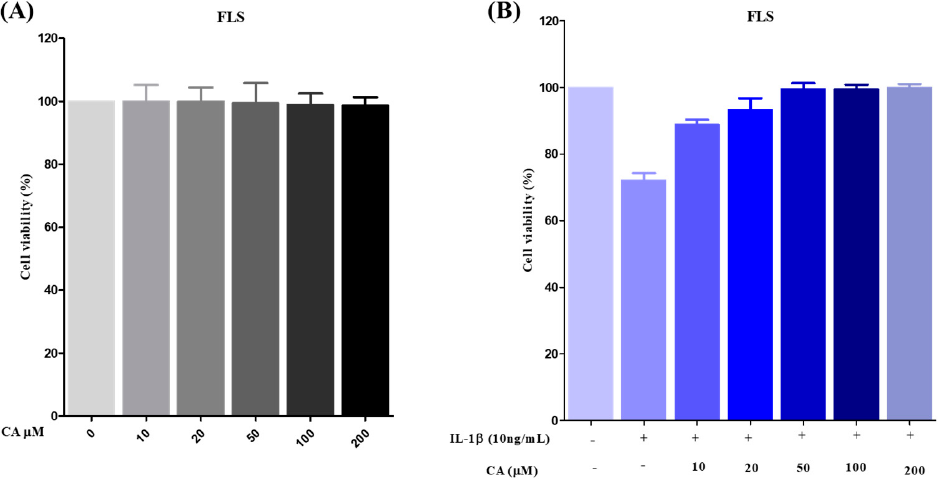
Figure 9. The cytotoxicity effect of CA was verified in FLS cells by ( A ) MTT assay with various concentrations of CA (0, 10, 20, 50, 100, and 200 µ M), and ( B ) antioxidant capacity was checked after ROS induction in FLS by IL-1 β and treatment with CA, 10 to 200 µ M. All experiments were conducted in triplicates and the data were expressed as mean ±